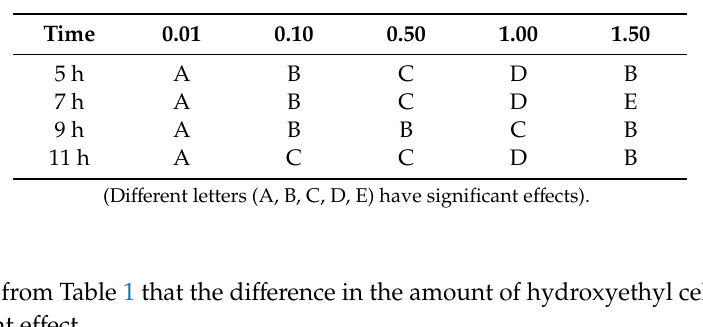
Figure 2. Effect of adding amount of thickener on removal capacity of new type of iron-carbon-loaded substrate (NICLS). Table 1. Significance analysis of